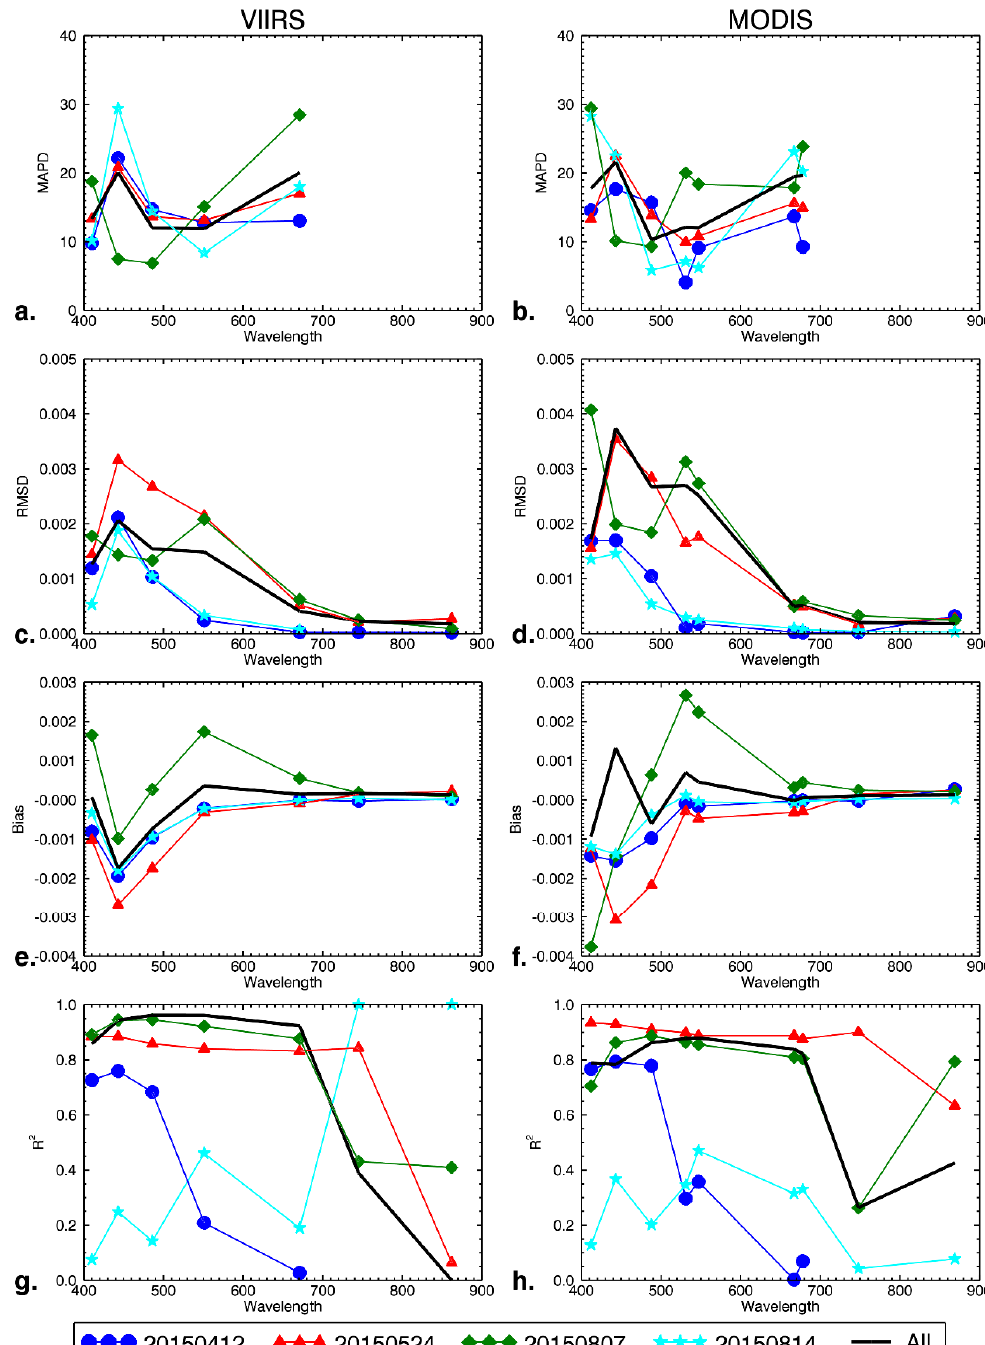
Figure 5. Spectrally resolved match-up summary statistics. ( a ) VIIRS MAPD; ( b ) MODIS MAPD; ( c ) VIIRS RMSD; ( d ) MODIS RMSD; ( e ) VIIRS bias; ( f ) MODIS bias; ( g ) VIIRS R 2 ; ( h ) MODIS R 2 . MAPD